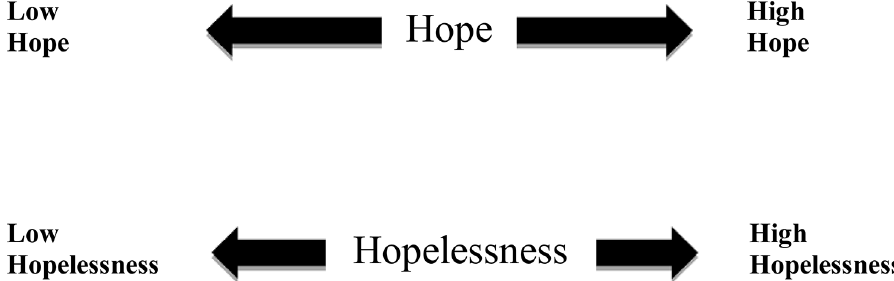
Fig 1. Hope and Hopelessness as Two Separate